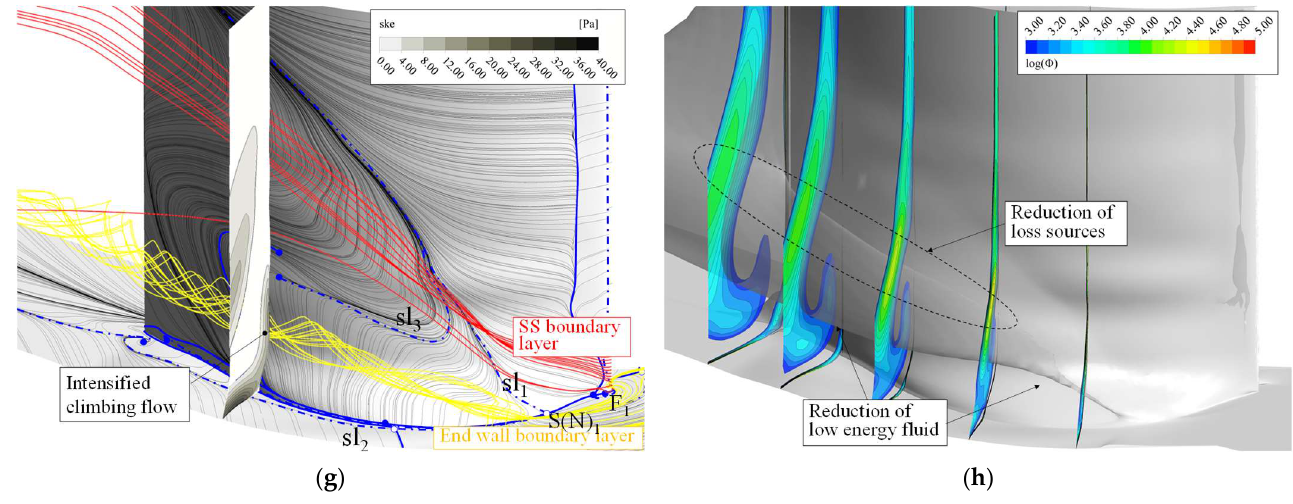
Figure 16. The flow field and distribution of loss source at the near-stall point. ( a ) Flow field of the baseline case; ( b ) loss source of the baseline case; ( c ) flow field of case A; ( d ) loss source of case A; ( e ) flow field of case B; ( f ) loss source of the case B; ( g ) flow field of case D; ( h ) loss of case D. According to Figure 16c,d, the positive effect of SS corner profiling in case A is just the same as at the design point. With the increase in the spanwise pressure gradient due to the convex shape of corner profiling, the acceleration of the climbing similarly suppresses its reverse trend and energies the accumulated low-energy fluid (as shown in Figure 16c). So, the separation line sl 2 is backward swept, and the shear loss at the border of the low-energy fluid is similarly reduced (as shown in Figure 16d). What makes a difference to the design point is its effect on the three-dimensional boundary layer flow. The end wall boundary layer flow (yellow streamlines in Figure 16c) turns to the spanwise direction as at the design point. However, the SS boundary layer (red streamlines in Figure 16c) directly rushes to the low-energy fluid. The shear loss at the top of the low-energy separation flow is thus not increased as at the design point.